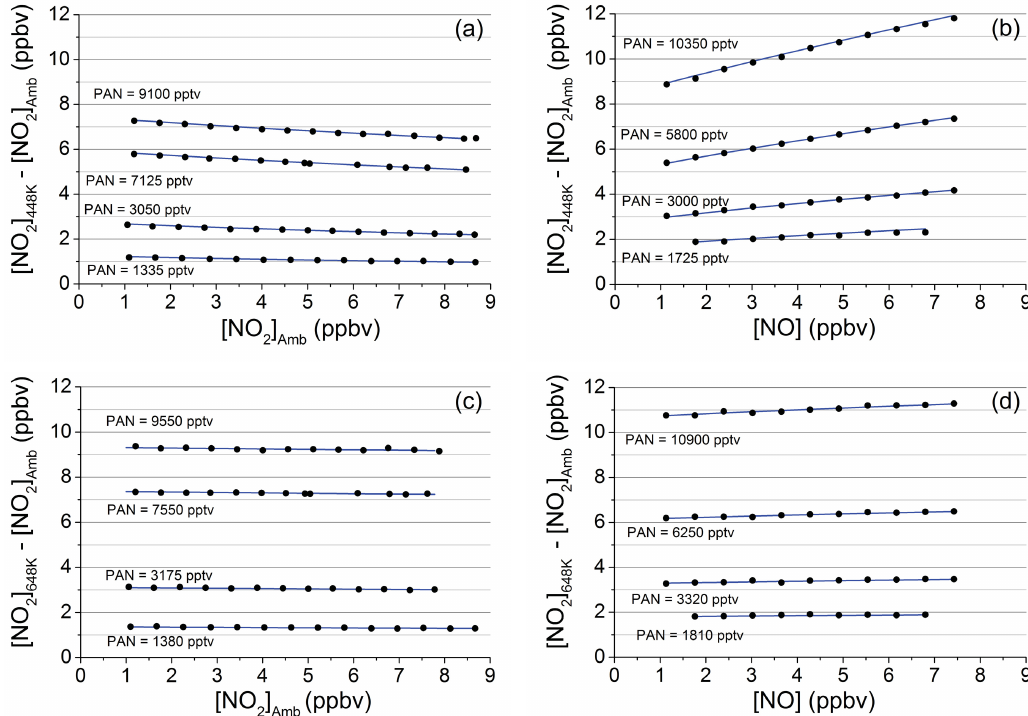
Figure 6. Modelled (lines) and measured difference between the NO 2 signal in the hot channels and ambient temperature channel for different PAN samples and different added amounts of NO and NO 2 . (a) Addition of NO 2 to the 448K (PNs) channel. (b) Addition of NO to the 448K (PNs) channel. (c) Addition of NO 2 to the 648K (ANs) channel. (d) Addition of NO 2 to the 648K (ANs)